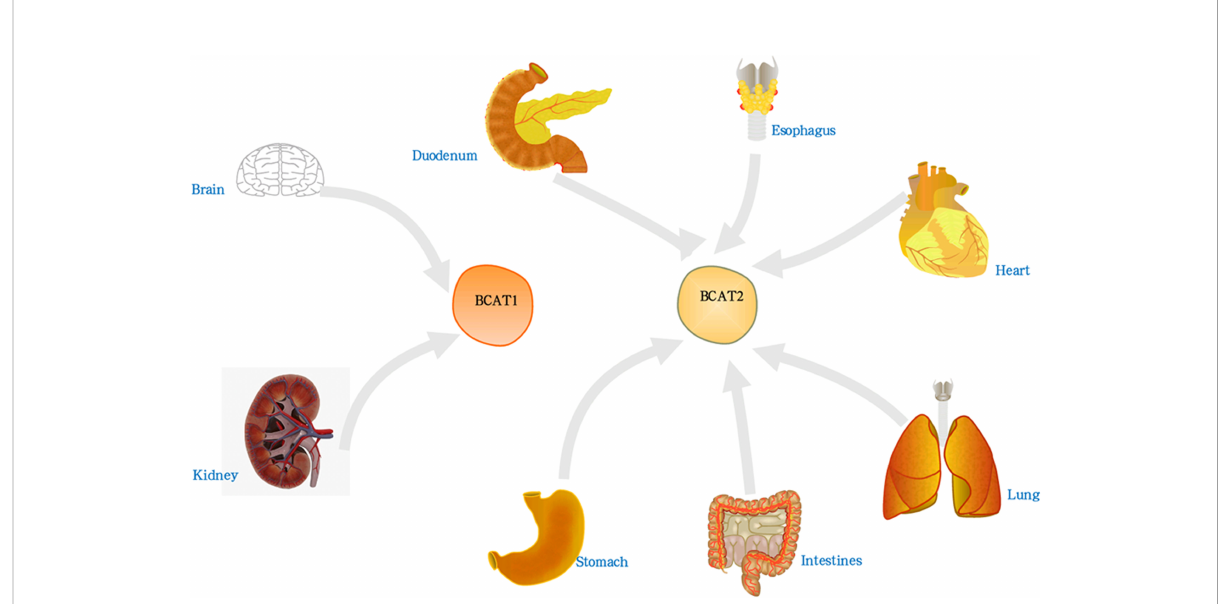
FIGURE 2 The distribution of BCAT in the human body. BCAT1 was present in brain, kidney and ovarian tissue. BCAT2 was expressed in all organs except liver, such as lung, brain, thorax,